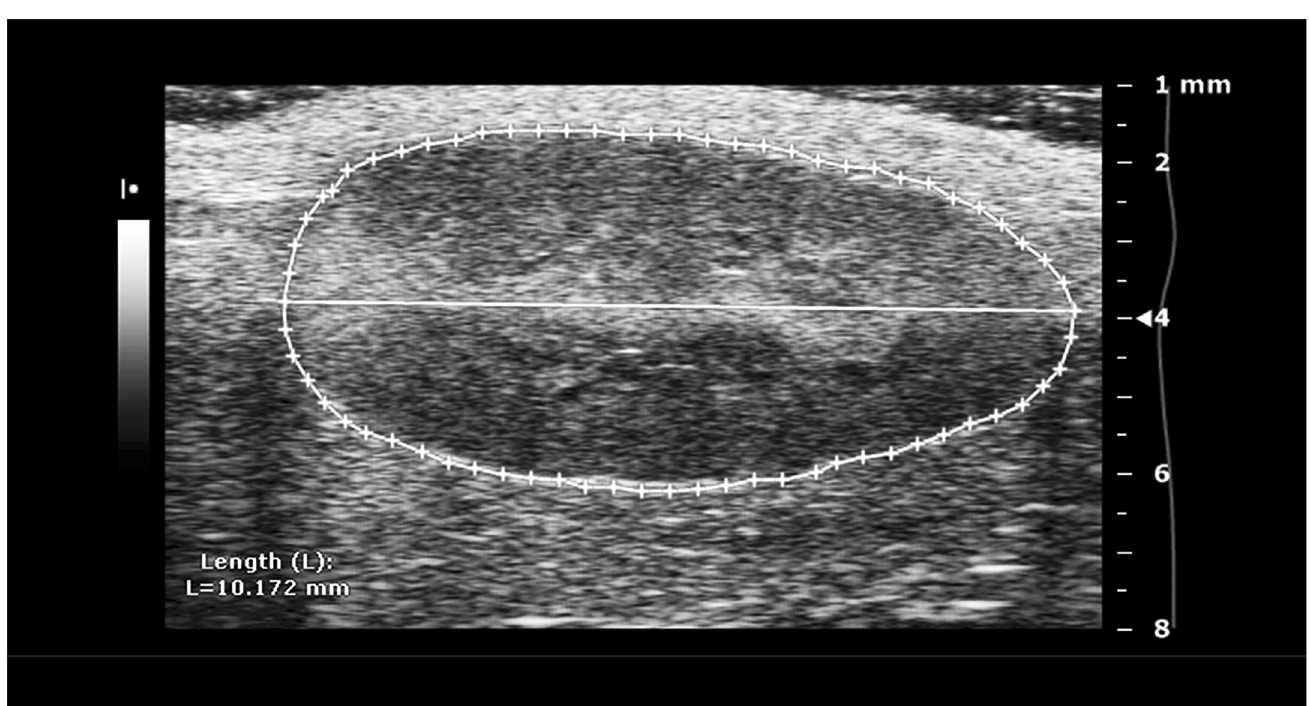
Fig 3. B-mode ultrasound measurement of kidney length in long-axis view. Off-line measurements of kidney length.